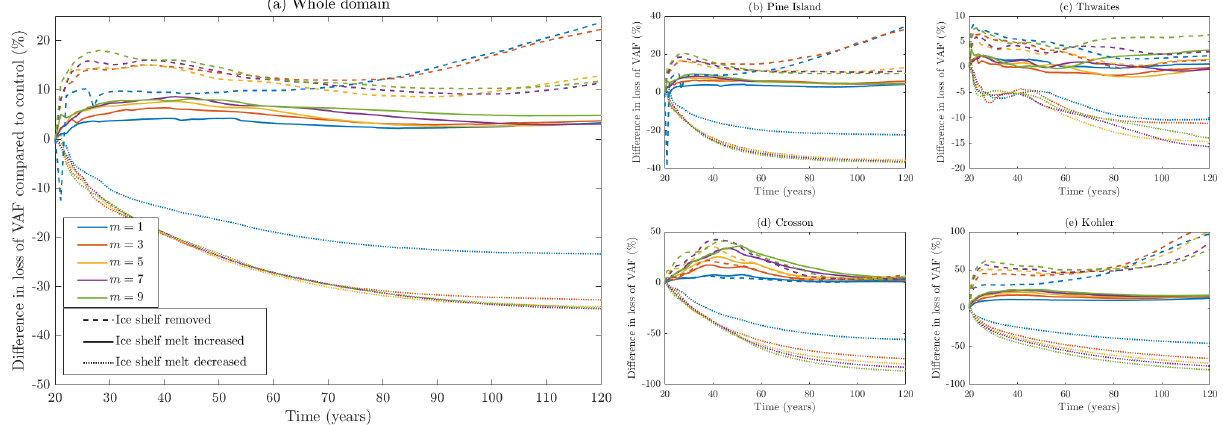
Figure 7. Additional VAF loss compared to the control branch for the Weertman sliding law with different values of m , showing the contributions of (a) the entire ASE domain and (b–e) each region within the domain. Note that the y axes for each region use different scales.